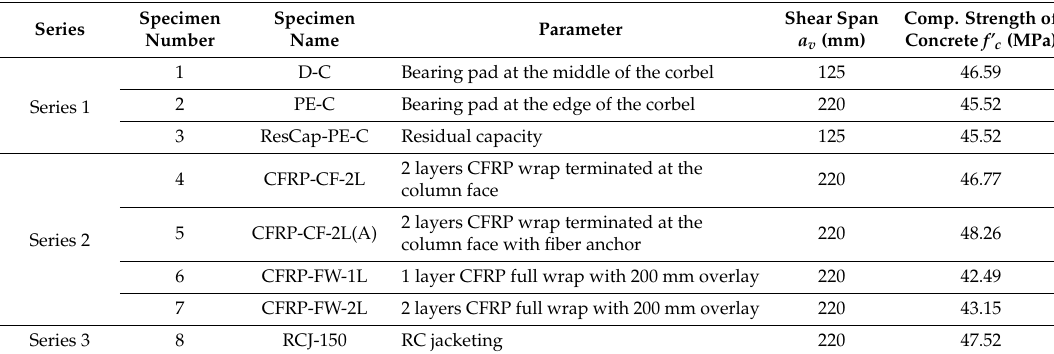
Table 1. Details of test series and